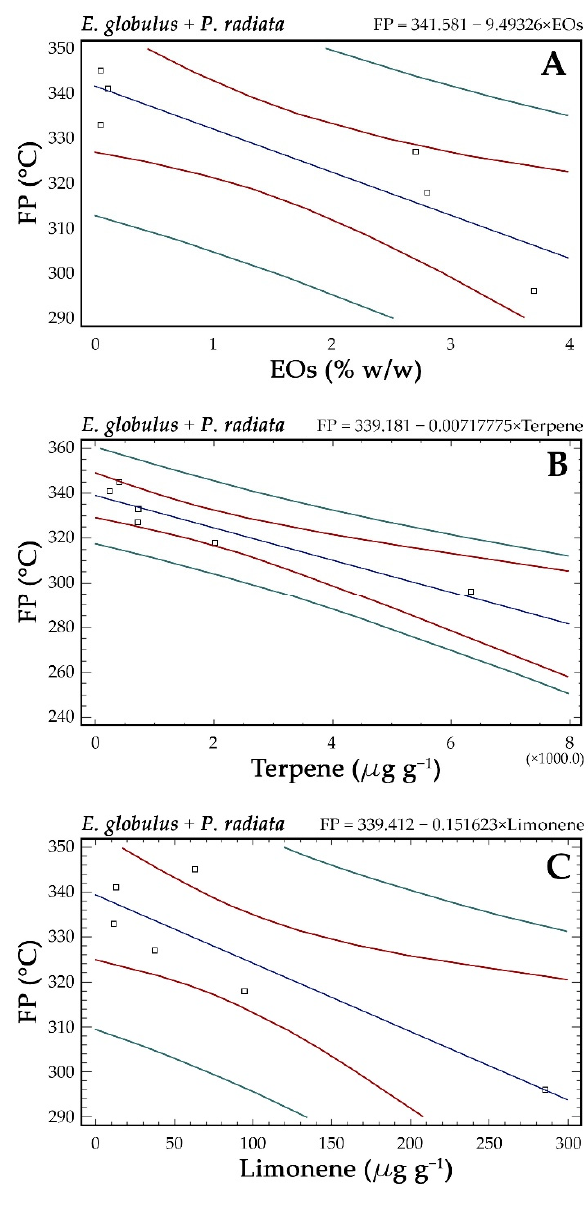
Figure 7. Statistically significant correlation between the flashpoints (FP) of Eucalyptus globulus and Pinus radiata samples with respect to their concentrations of ( A ) essential oils (EOs), ( B ) terpenes, and ( C ) limonene. Empty black squares represents data points, while blue strait line represents the least squares regression fit. Red lines (inner limits) represent the confidence interval, while green lines (external limits) represent the prediction limits, both at 95% confidence level.